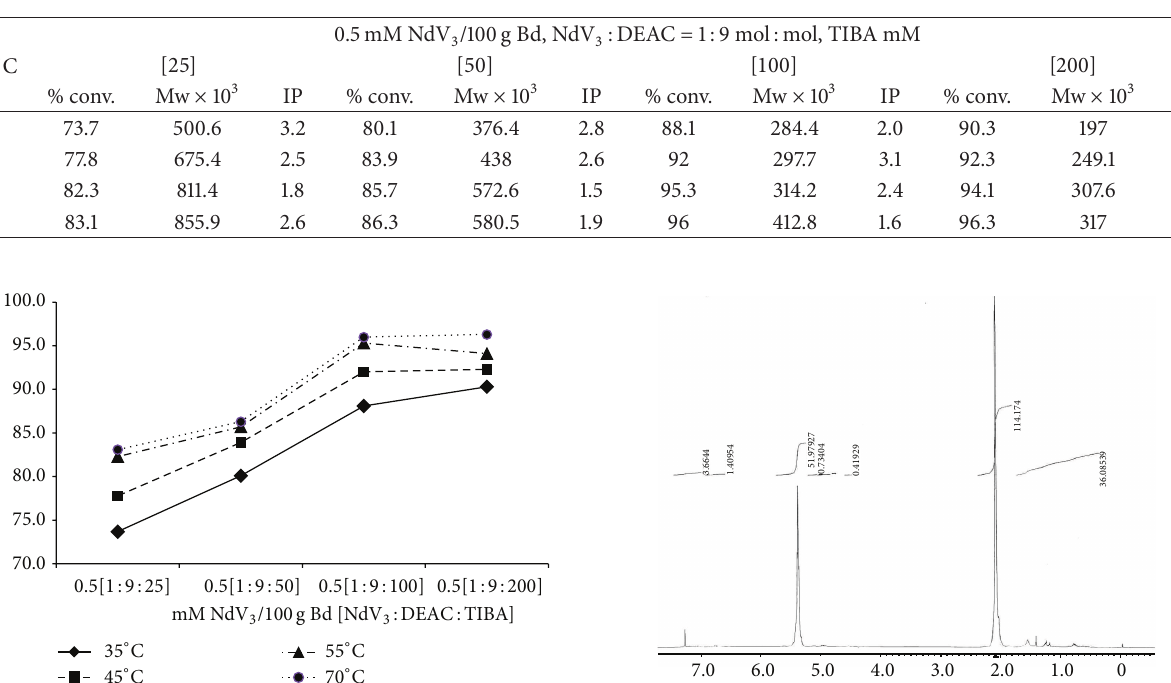
Table 1: Molecular weight and conversion of high cis -1,4-BR.